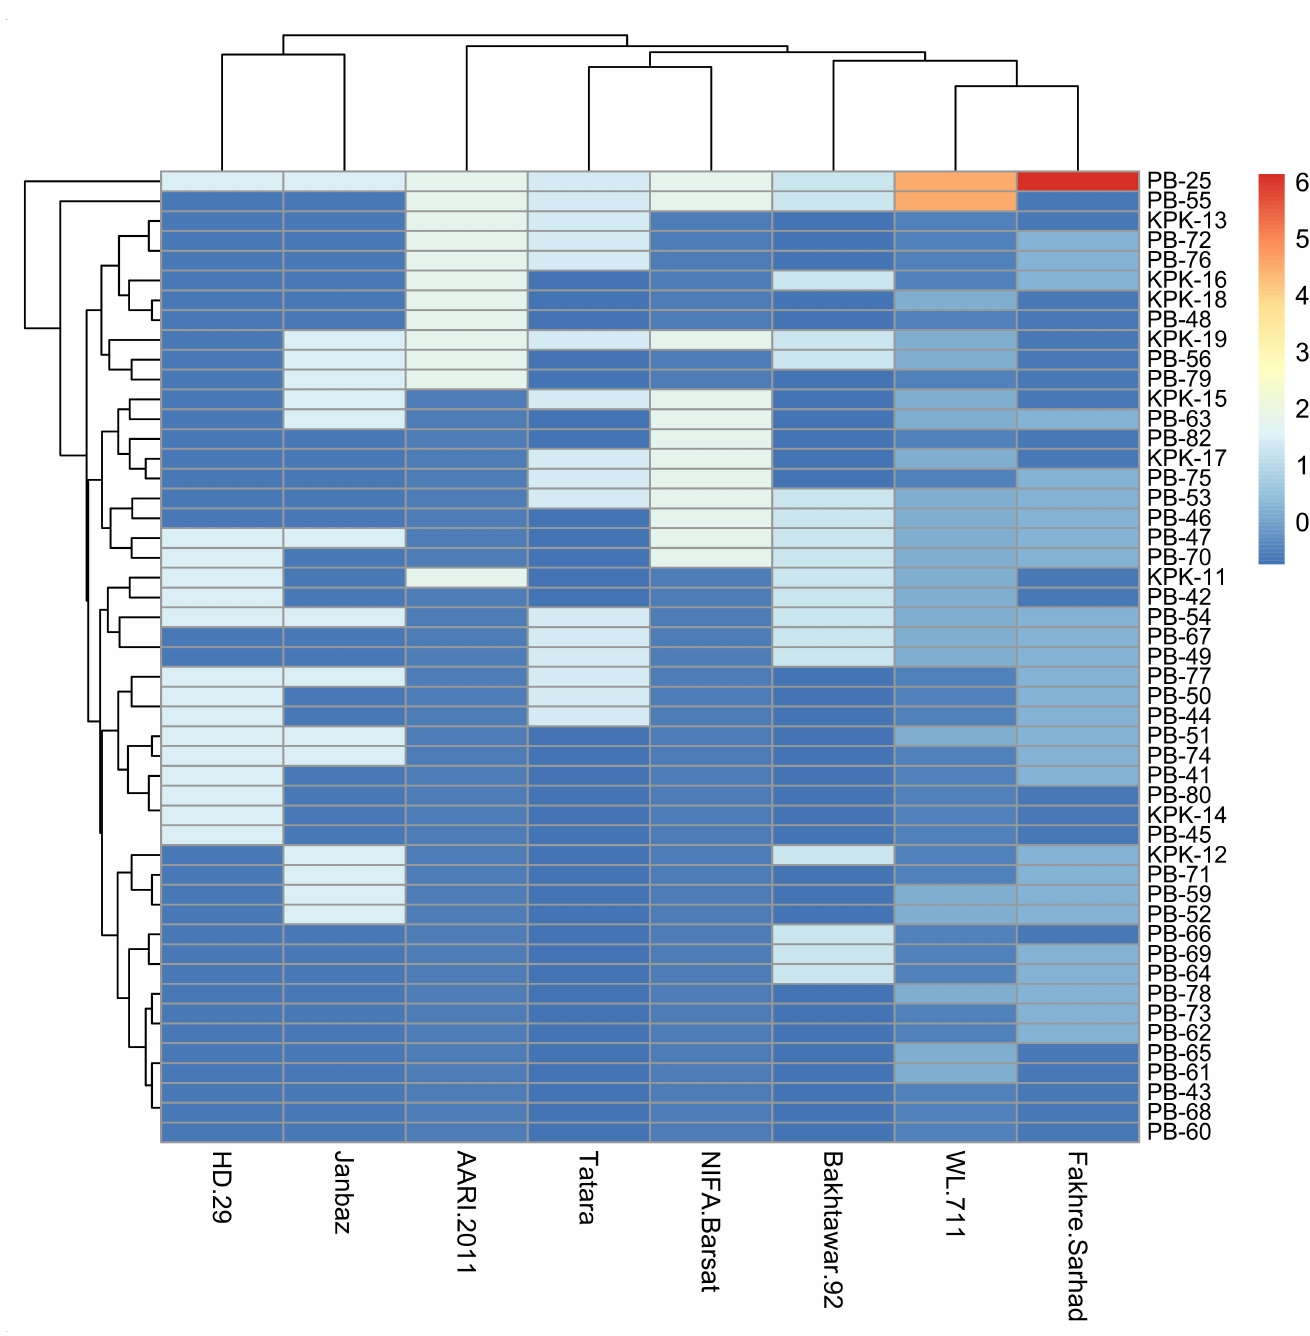
Figure 2. Grouping of forty-nine isolates based on coefficient of infection on eight wheat